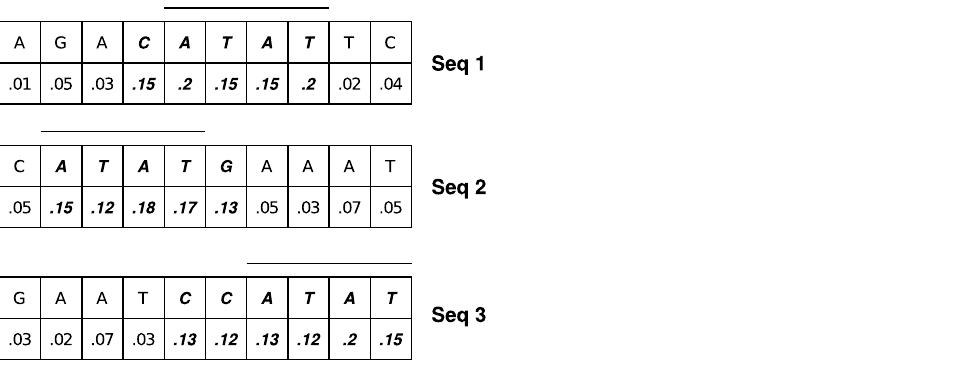
Figure 3. An illustrative example for motif